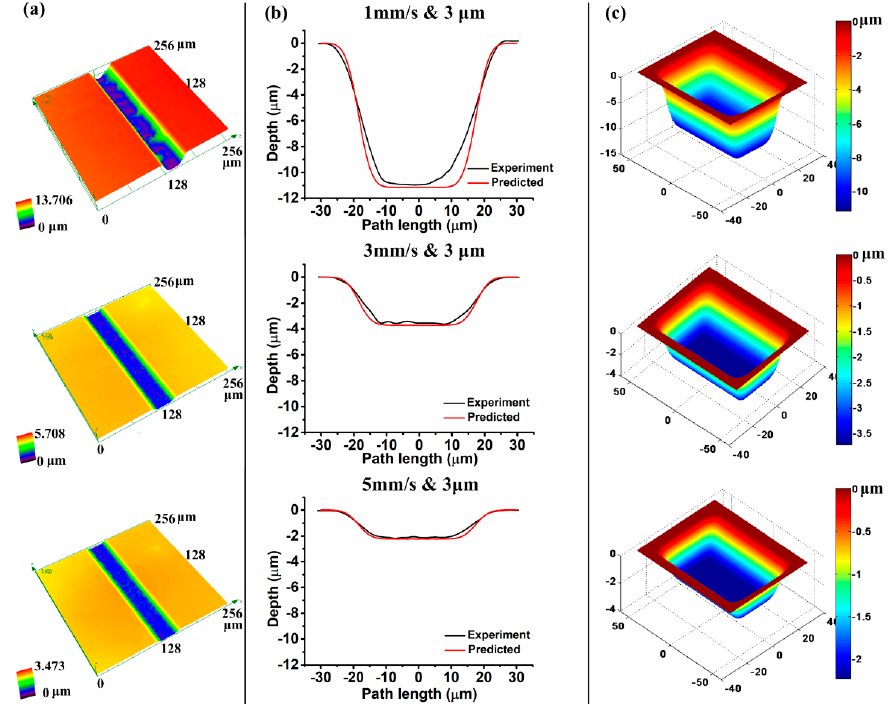
Figure 6. The comparison between experimental and predicted micro-channels for different scanning speeds: ( a ) measured micro-channels, ( b ) comparison of cross-sectional profiles, and ( c ) predicted micro-channels.